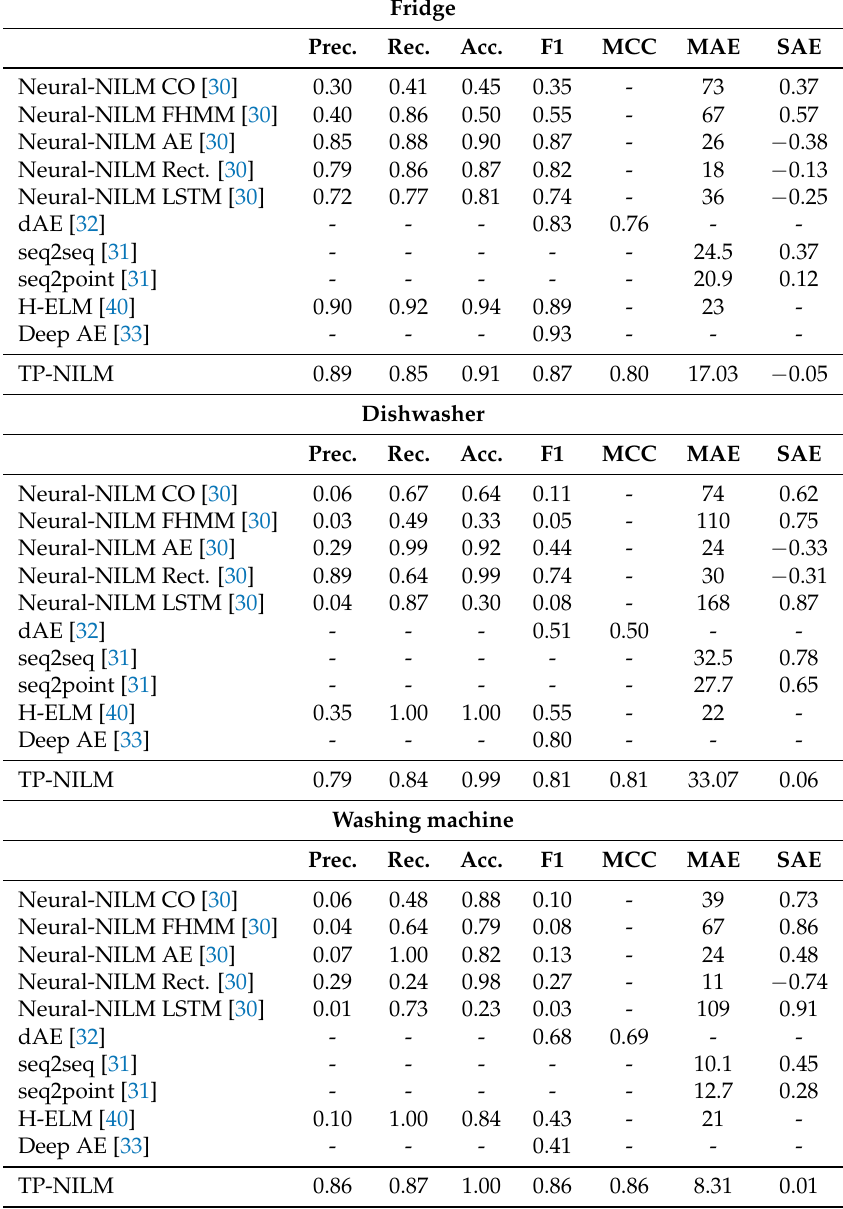
Table 7. Performance comparison for the unseen case on the UK-DALE dataset. The models used for comparison are based on Combinatorial Optimization (Neural-NILM CO), Hidden Markov Model (Neural-NILM FHMM, ON-line-NILM), Convolutional Neural Network (Neural-NILM AE, Neural-NILM Rect., dAE, seq2seq, seq2point, Deep AE), Recurrent Neural Networks (Neural-NILM LSTM) and Extreme Learning Machine